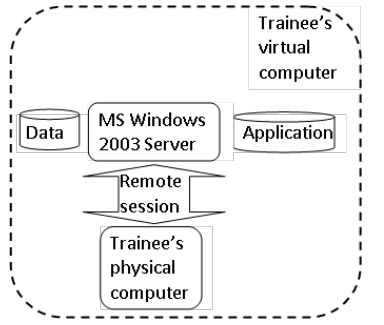
Fig. 4. Topology of trainee’s virtual computer after connection to the server